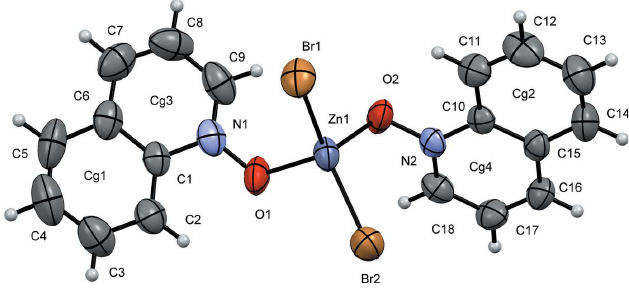
Figure 2 A view of compound ( II ), showing the atom labeling. Displacement ellipsoids are drawn at the 50% probability level.